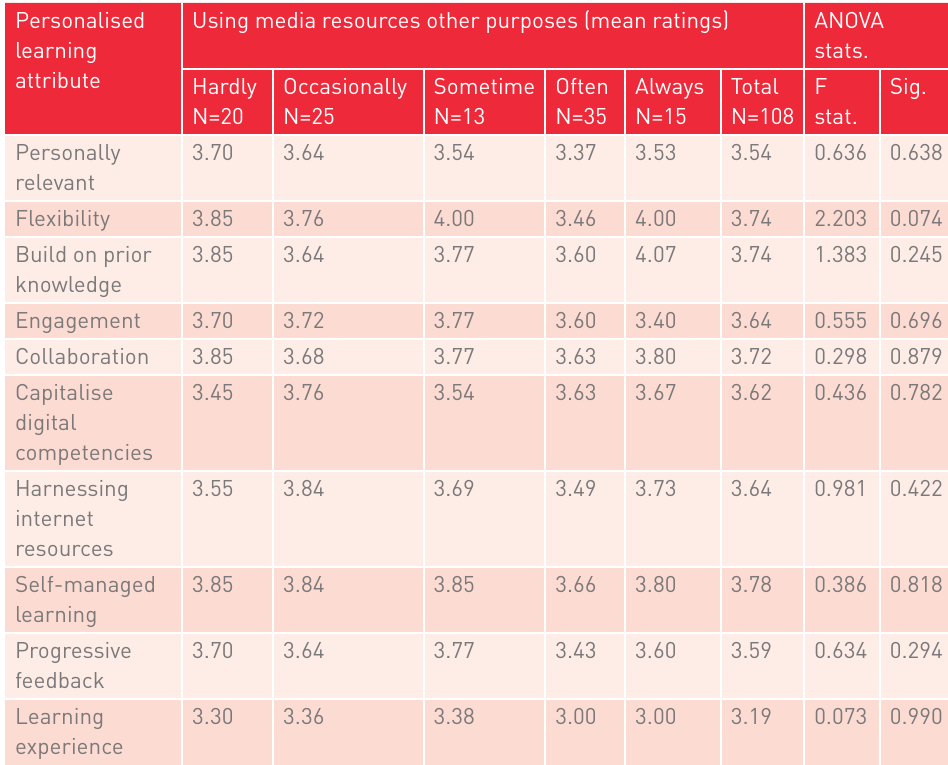
ANOVA test results for digital experience of student